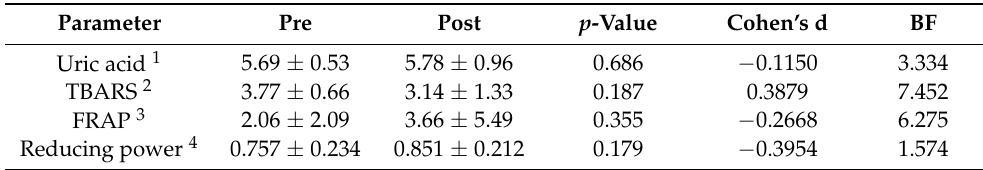
Table 3. Pre/post biochemical parameters in plasma of novice jiu-jitsu athletes in their first official competitions (N =